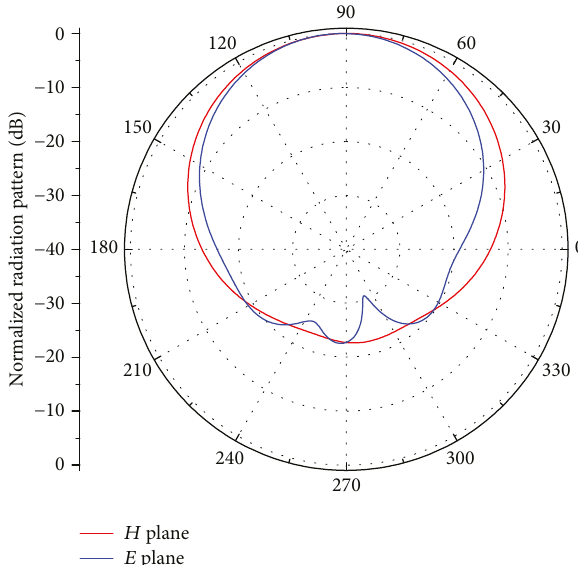
Figure 19: Normalized radiation pattern of the SIW antenna.